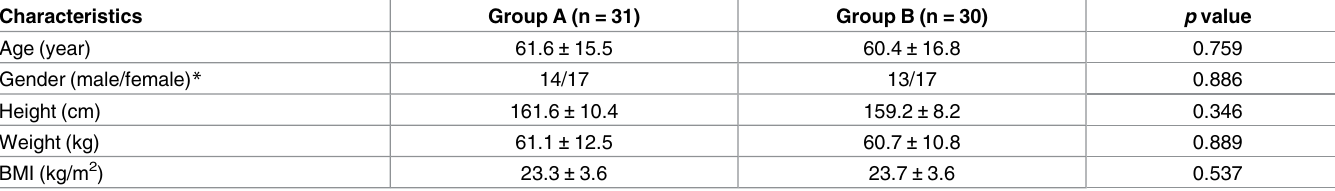
Table 1. Comparison of patient characteristics (n =